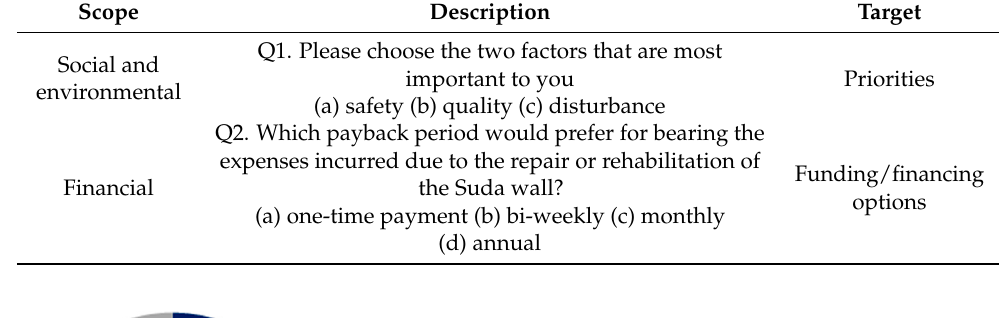
Table 4. The survey questionnaire.